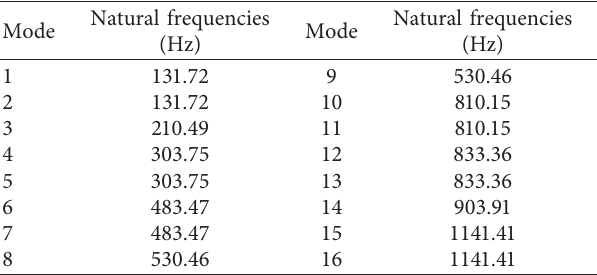
Table 2: Natural frequencies of the finite element model of the